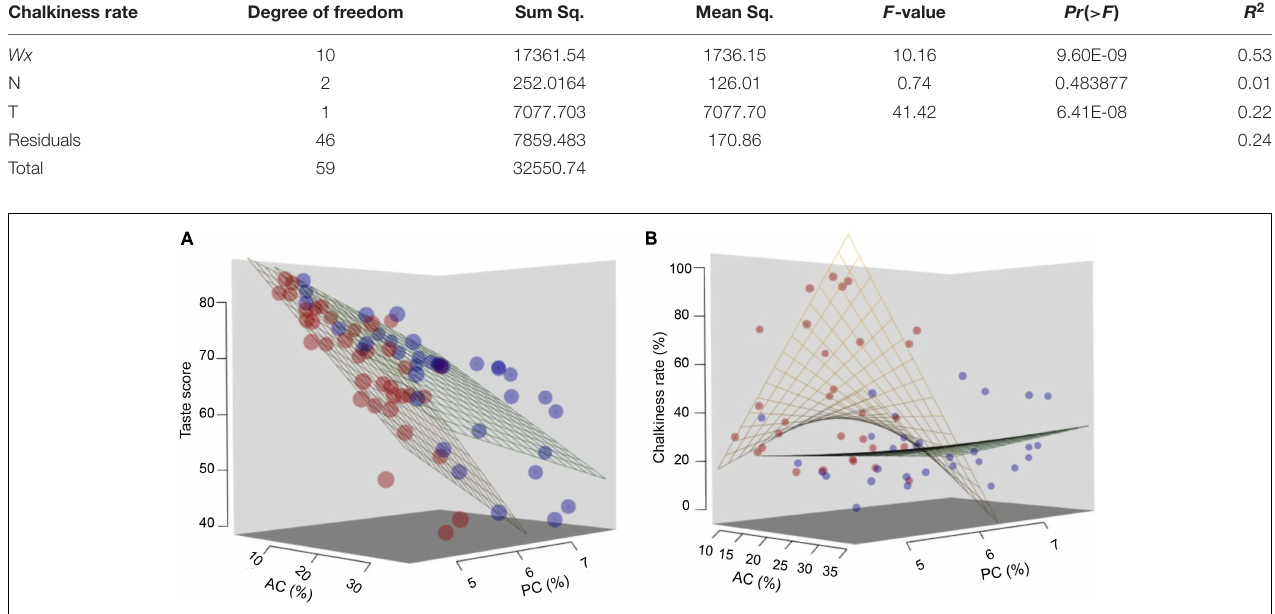
FIGURE 5 | Analysis of the regression relationships on AC, PC, and temperature. Regression analyses of (A) taste score; (B) CR on AC, PC, and temperature. Red dots represent the phenotype [AC, PC, and taste score in (A) or CR in (B) ] at HT and blue points represent the phenotype at normal temperature. The red and blue latticed surfaces represent the regression surfaces of the phenotypes at high and normal temperatures,